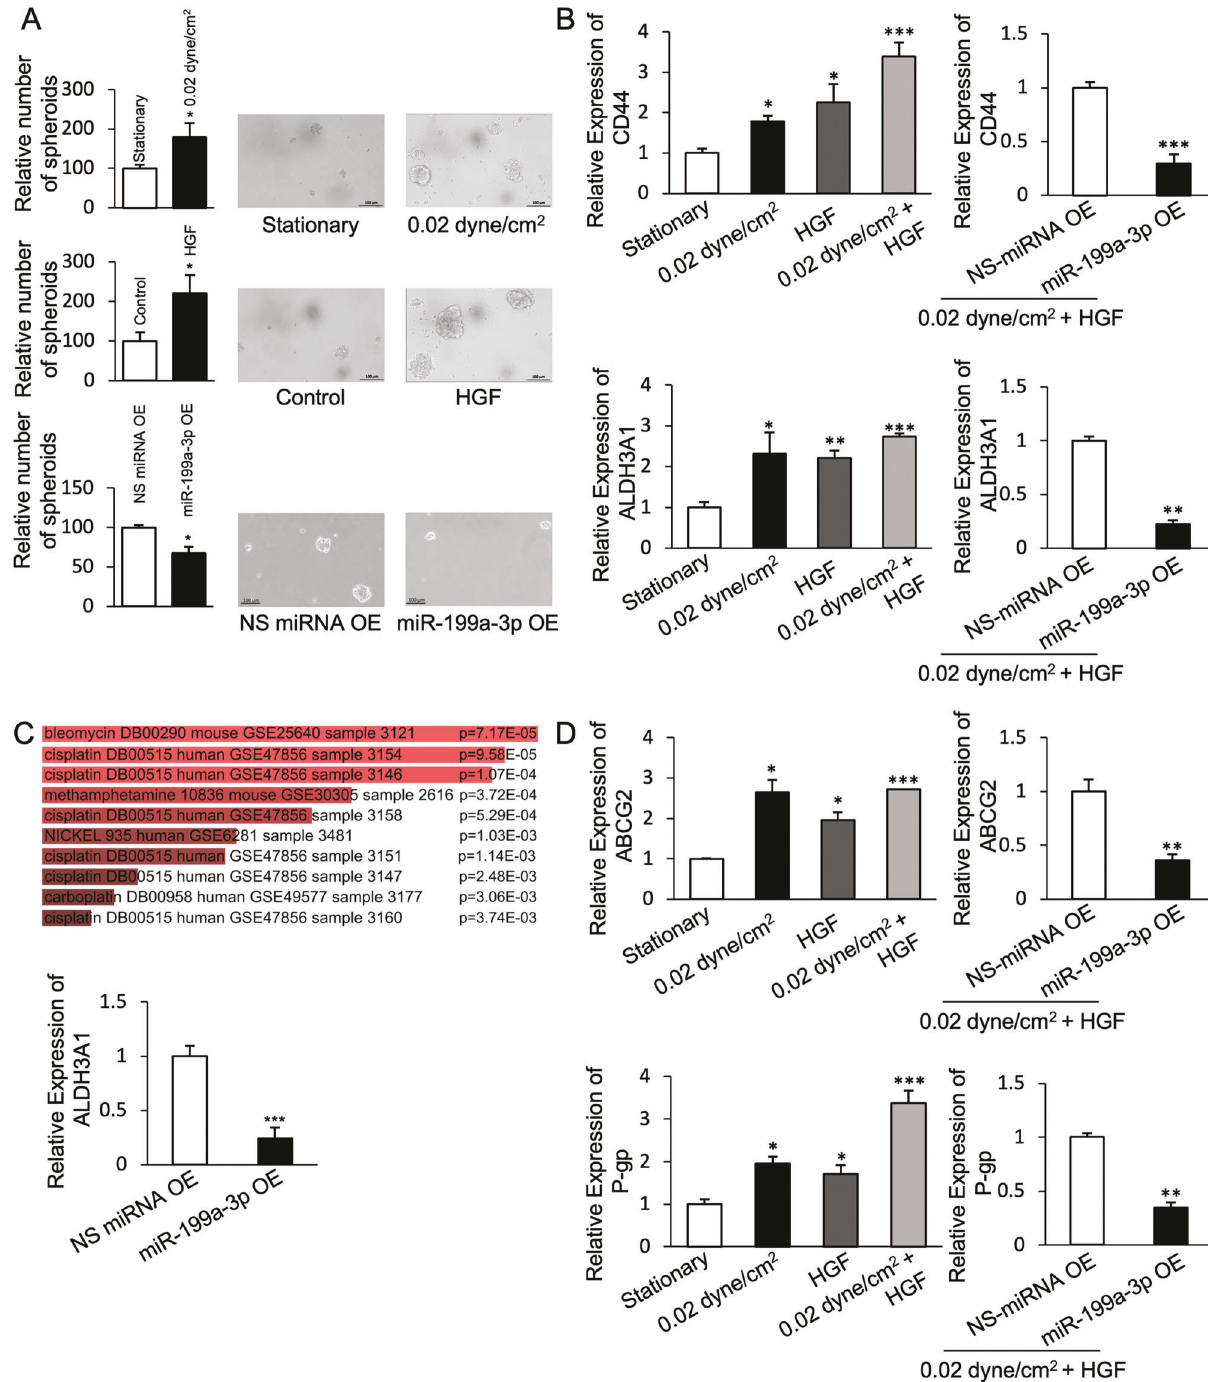
Fig. 4 miR-199a-3p enhances stemness in ovarian cancer cells. A Relative number of spheroids formed under shear stress and HGF treatment, and in miR-199a-3p overexpressing cells. Scale bar, 100 μ m. B Expression of CD44, and ALDH3A1 under shear stress an HGF combined treatment, and their expression in miR-199a-3p overexpressing cells. C List of drug metabolism pathways in EnrichR database correlated with shear stress upregulated genes sets from whole cell RNA sequencing and expression of ALDH3A1 in miR-199a-3p overexpressing cells. D Expression of ABCG2 and P-gp under shear stress and HGF combined treatment, and their expression in miR-199a-3p overexpressing cells. Bar graph values are mean ± SD, n = 3. T -test. * P < 0.05, ** P <